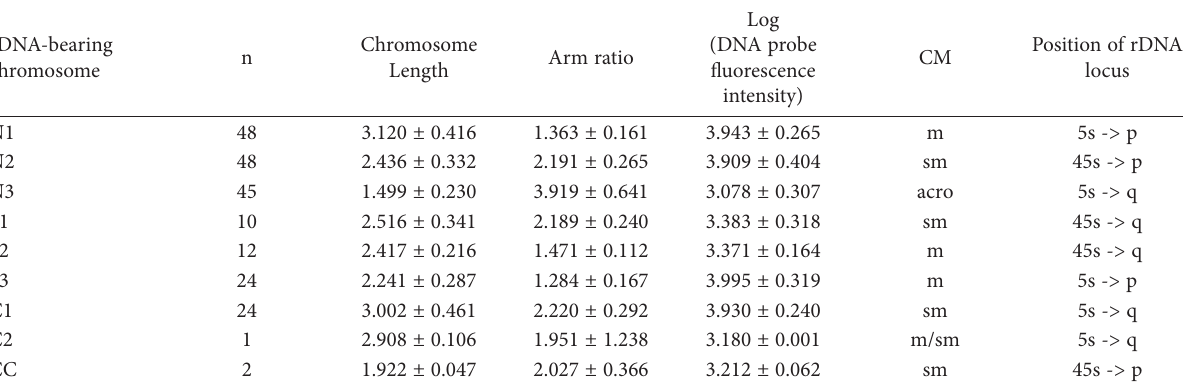
Table 1. Morphometric and fluorescence data of the nine types of chromosomes found in Physalis peruviana L. populations.